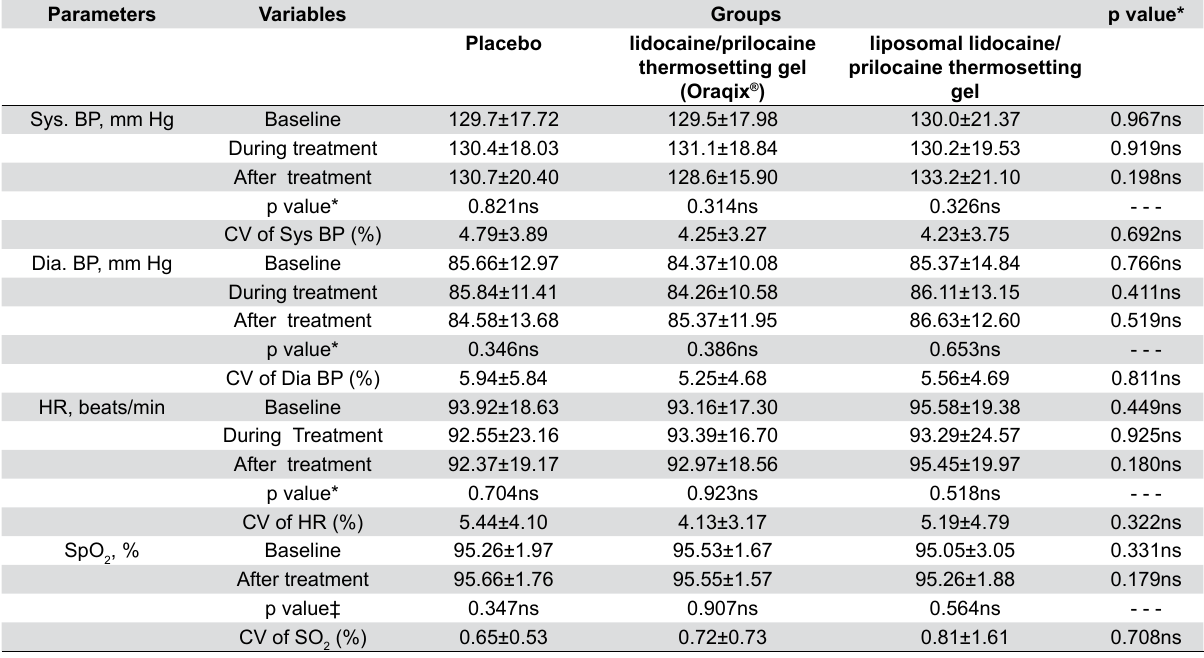
Table 3- Comparison of mean (±SD) values of hemodynamic parameters